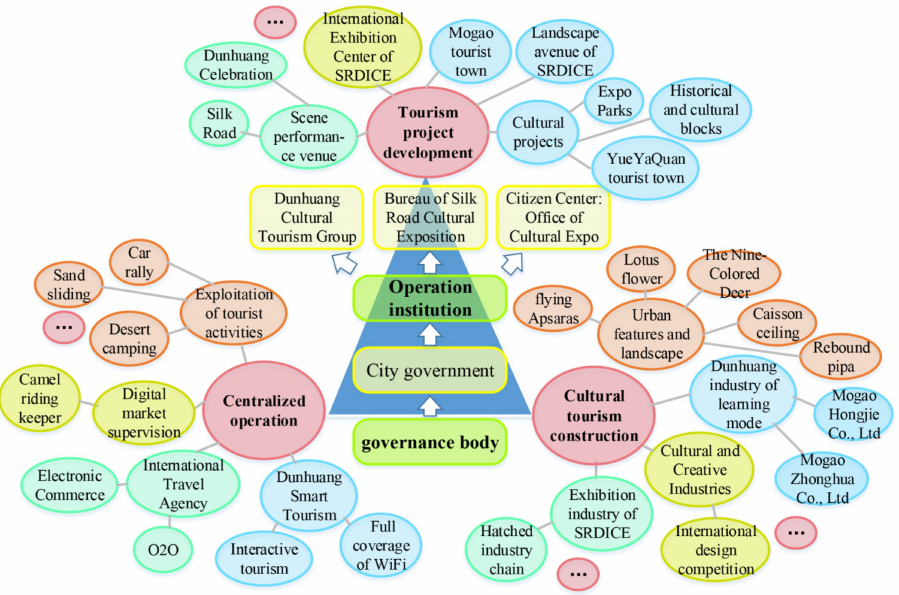
Figure 10. Governance mechanism in the centralized operation and global city marketing